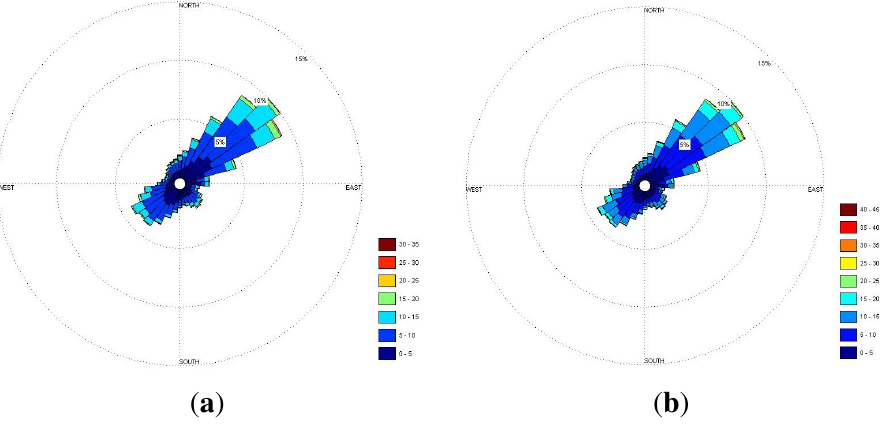
Figure 2. Wind rose diagrams of the measured 10-m wind ( a ) and 55-m wind ( b ).